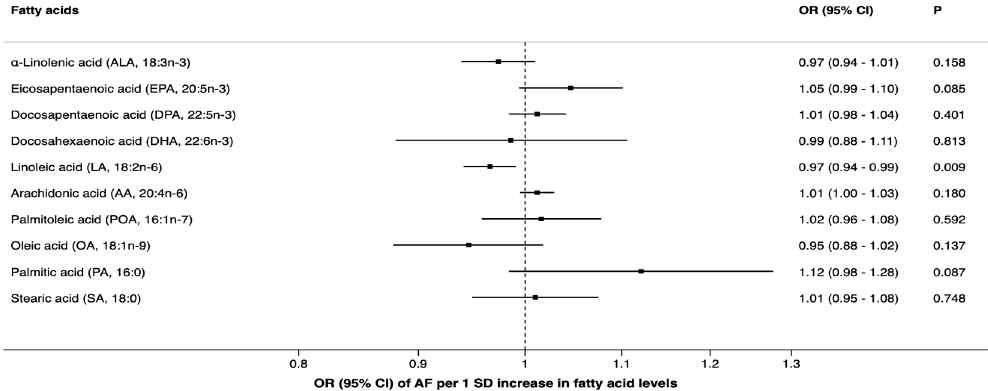
Figure 2. Associations of plasma fatty acid levels with risk of atrial fibrillation in Mendelian randomization analyses (fixed-e ff ects inverse-variance weighted model). AF indicates atrial fibrillation; randomization analyses (fixed-effects inverse-variance weighted model). AF indicates atrial CI, confidence interval; OR, odds fibrillation; CI, confidence interval; OR, odds ratio.